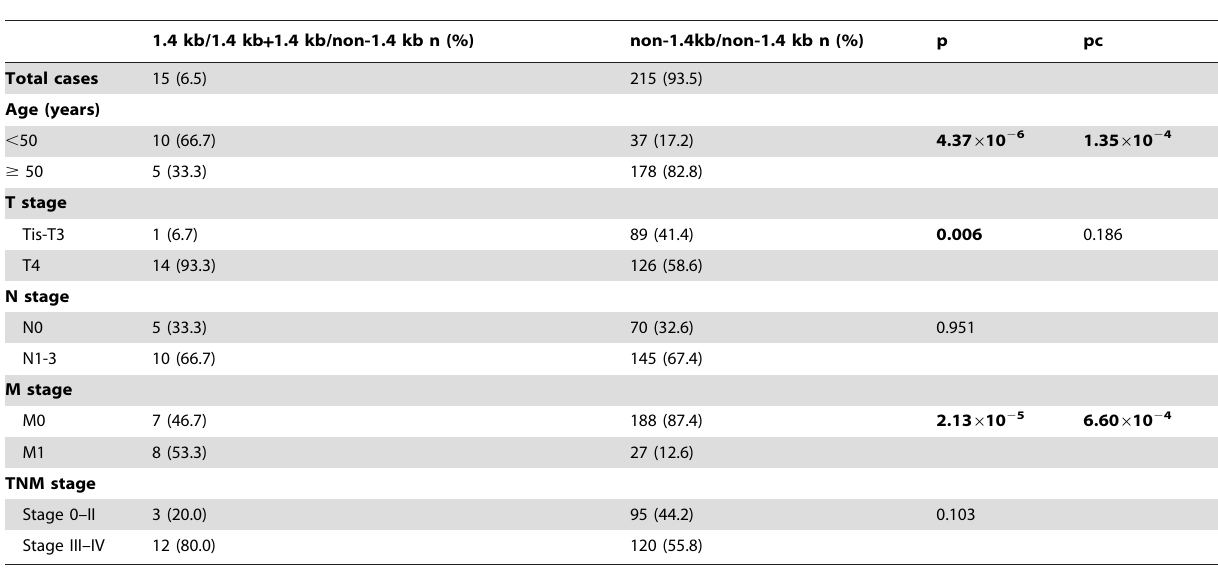
Table 3. Clinical and pathological characteristics of GC patients with MUC5AC-u repetitive region 1.4 kb allele.